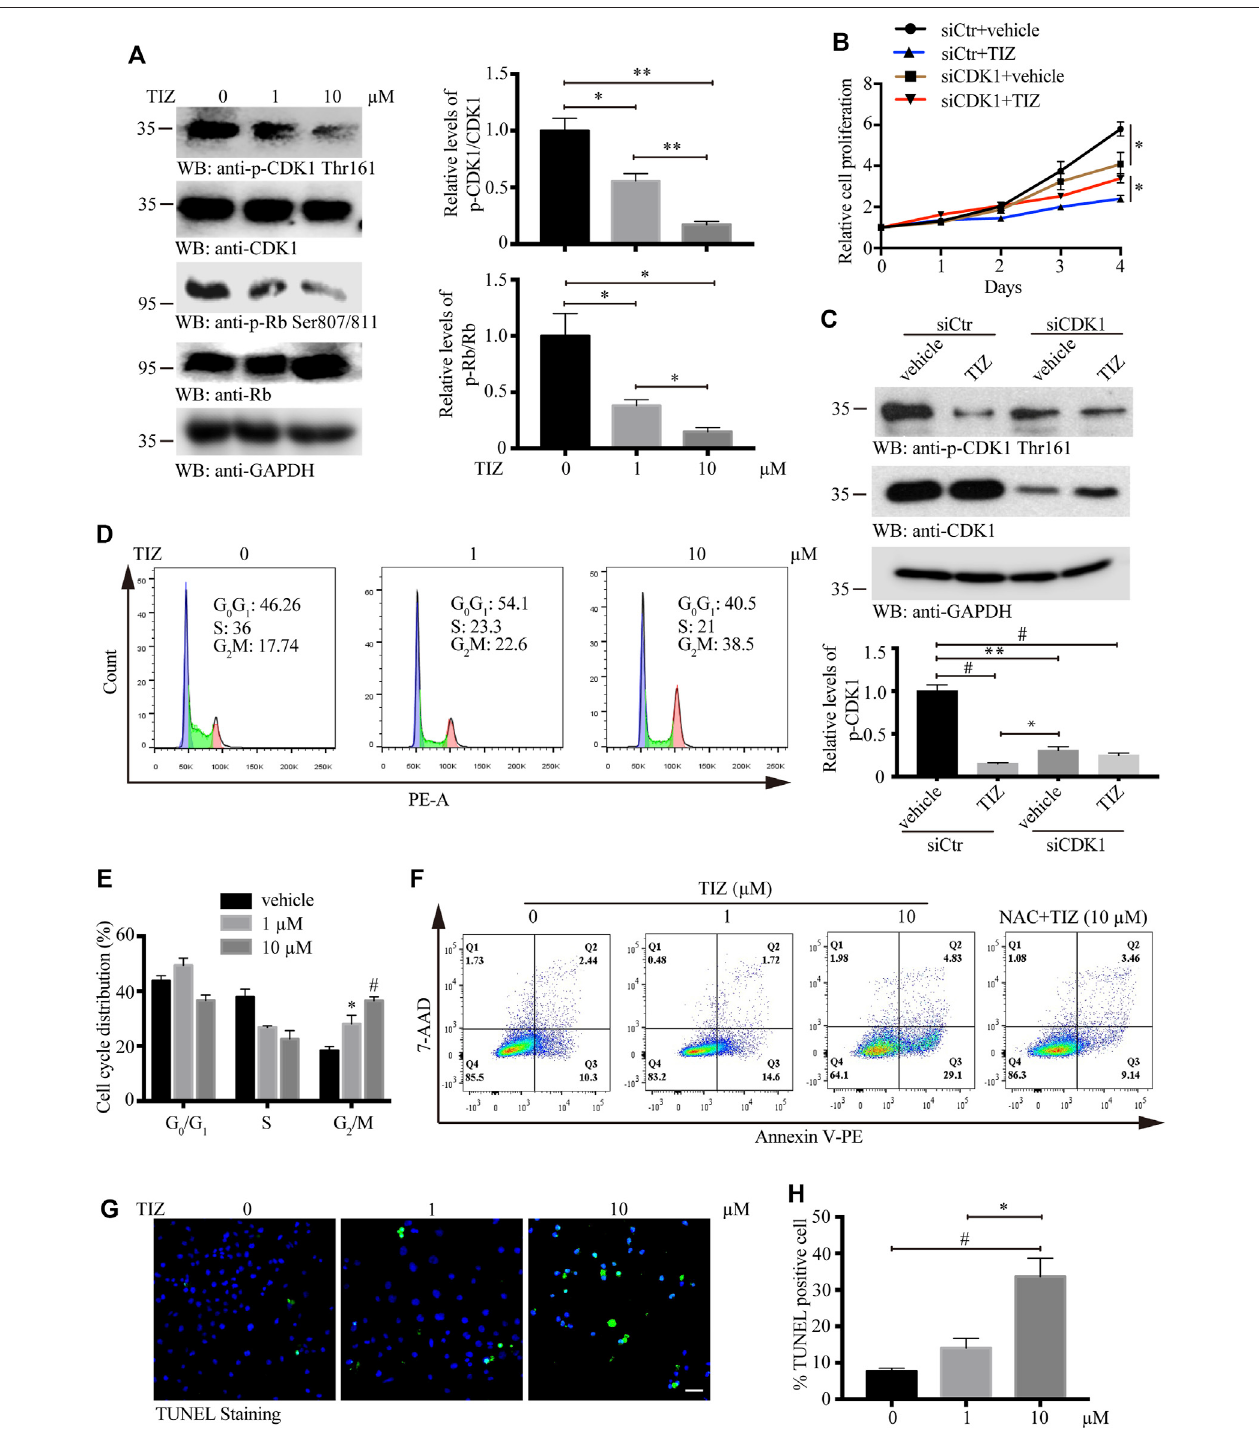
FIGURE3| TIZarreststhecellcycleattheG2/MphaseandinducesapoptosisofGMBbyinhibitingtheactivitiesofCDK1. (A) TIZinhibitstheactivityofCDKs.U87MGcells weretreatedfor48 hwiththeindicatedconcentrationofTIZ.Celllysateswereimmunoblottedwithanti-phosphoCDK1Thr161,amarkerofactivatedCDK1,andanti-phosphoRb Ser807/811,amarkerofcellularCDKactivity.Right,Quanti fi cationoftherelativelevelsofp-CDK1Thr161andp-RbSer807/811( n =3). (B) CCK-8assayofU87MGcellstreated withTIZ(10 µM)orsiCDK1ortheircombinationforupto4 days. (C) WesternblotanalysisofU87MG cellstreatedwith TIZ (10 µM),siCDK1,or theircombination for 48 h. Down, quanti fi cation of the relative levels of CDK1 ( n = 3). (D) Flow cytometric analysis of cycle distribution showed that TIZ arrested the cell cycle of U87MG cells at the G2/M phase. (E) Quanti fi cationofcycledistributioncon fi rmedG2/Mphasearrest( n =3). (F)